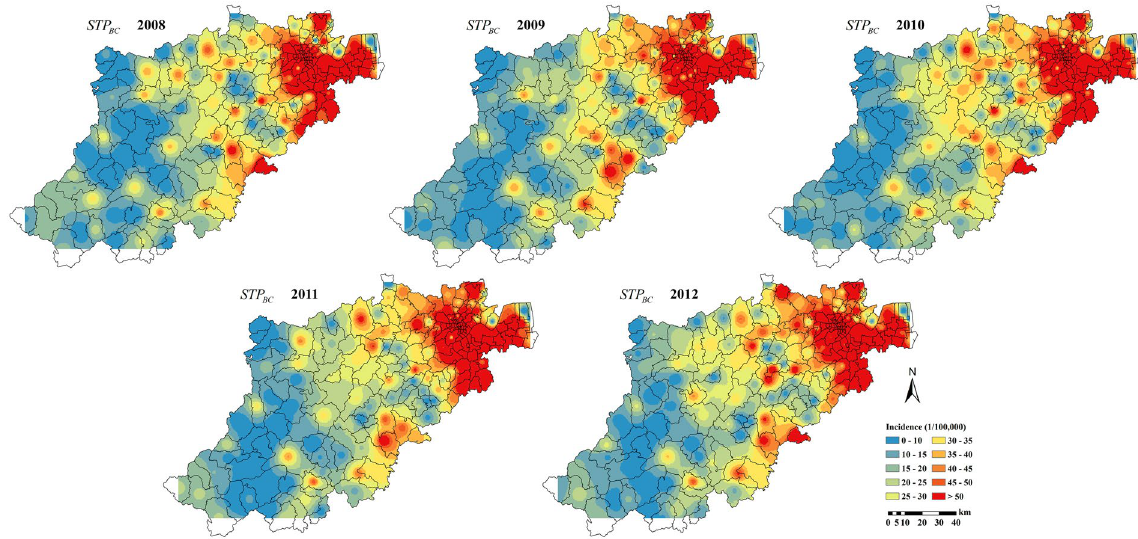
Figure 8. STP estimation maps of the BC incidence distribution in Hangzhou city during 2008–2012. Maps were generated using ArcGIS 9.3. URL link: